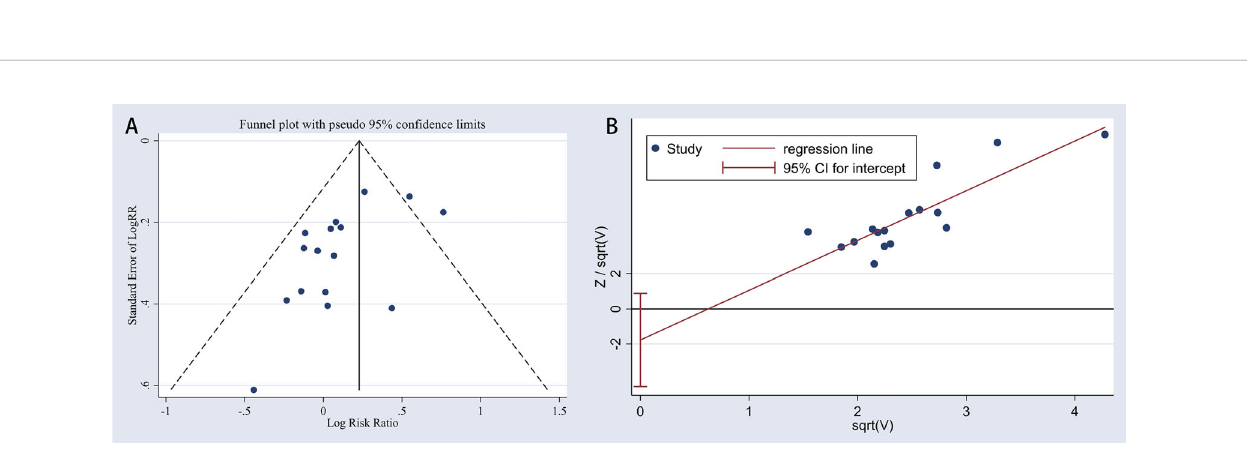
FIGURE 9 | Publication bias in the meta-analysis. (A) , funnel chart; (B) , Harbord test plot.